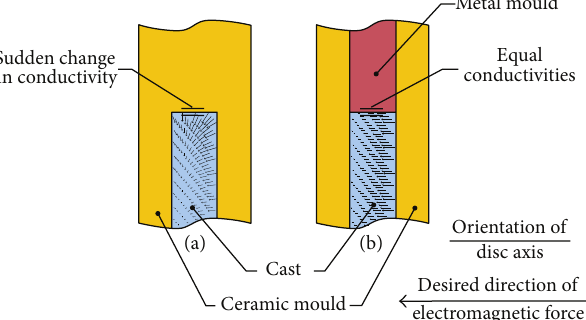
Figure 2: Zone of the disc edge: (a) standard mould, (b) mould with metal elements ensuring a uniform distribution of the